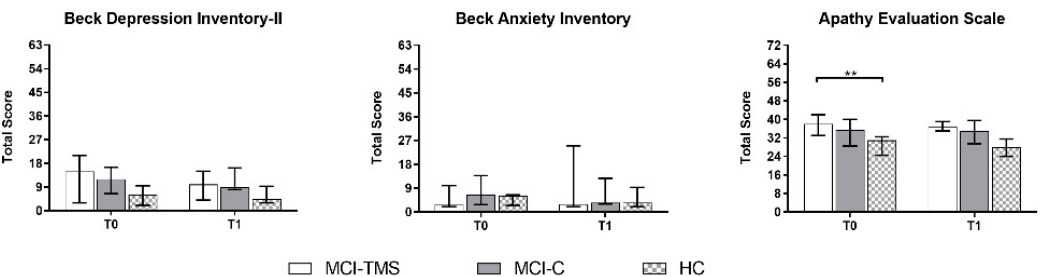
Figure 3. Between-group comparison on behavioral measures at T0 and T1 (pre- and post-treatment) using Quade’s rank analyses of covariance; Benjamini–Hochberg-corrected ** p ≤ 0.01.